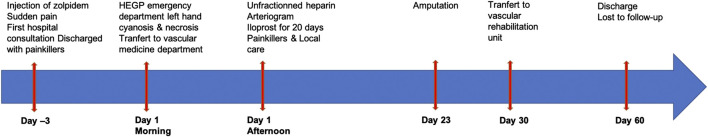
Timeline summary.